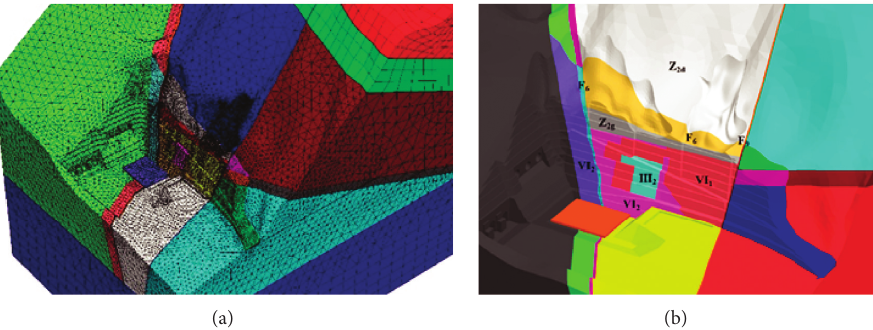
Figure 4: (a) Grid model after slope excavation. (b) Main stratigraphic lithology and structural plane distribution.